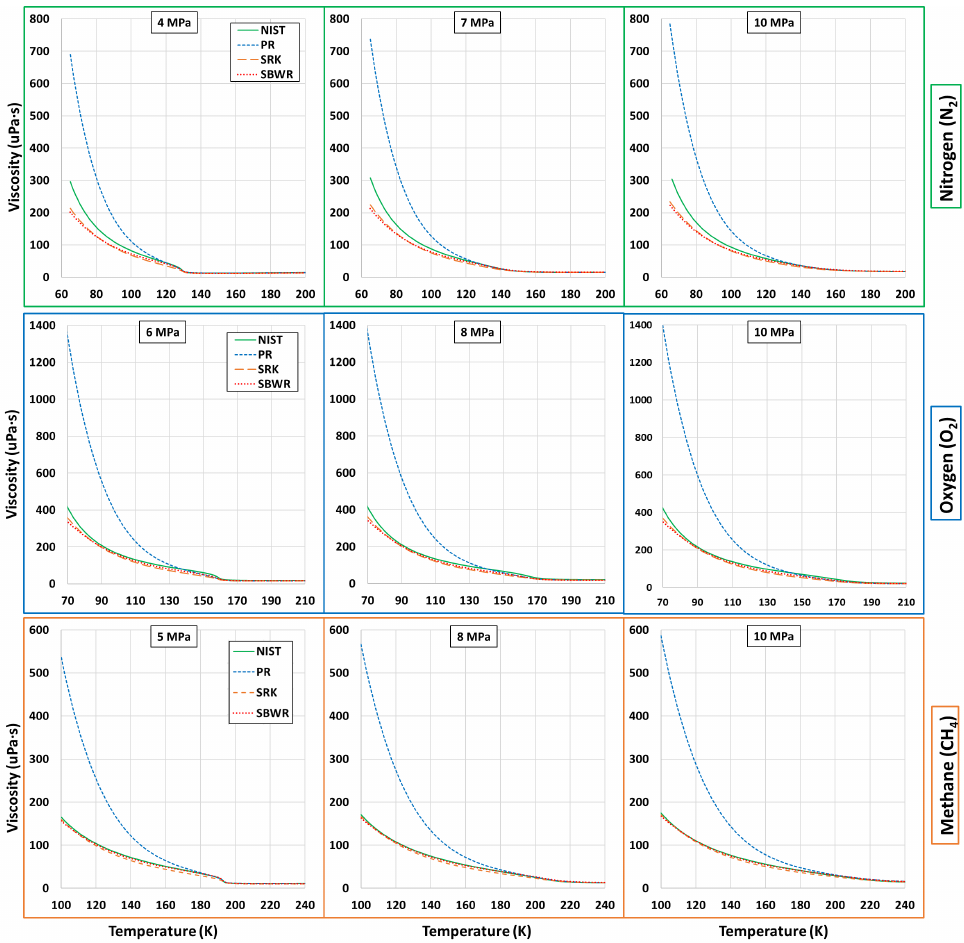
Figure 5. Plots of estimated viscosity using Chung et al.’s model and density from PR, SRK and SBWR compared against NIST for cryogenic fluids (N 2 , O 2 and CH 4 ) at three supercritical